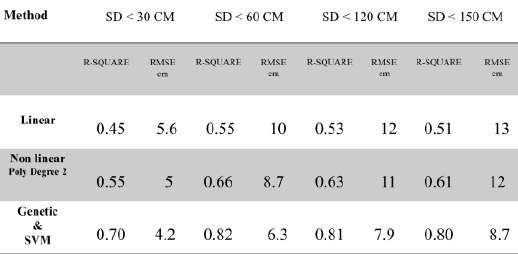
Figure 6. Convergence of Genetically-SVM Table 2. Snow depth retrieval result for different snow frequency using linear, nonlinear, genetically